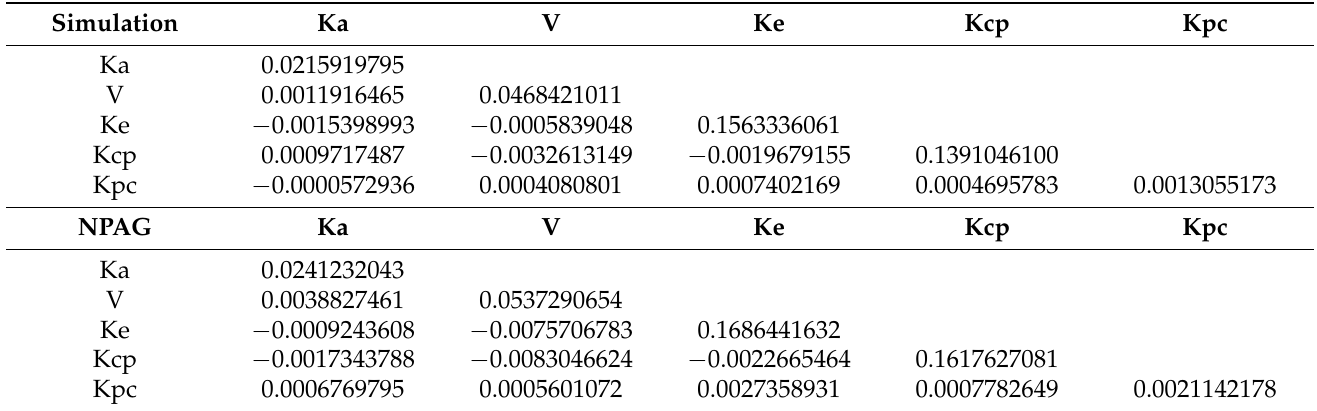
Table A2. Parameter Covariance